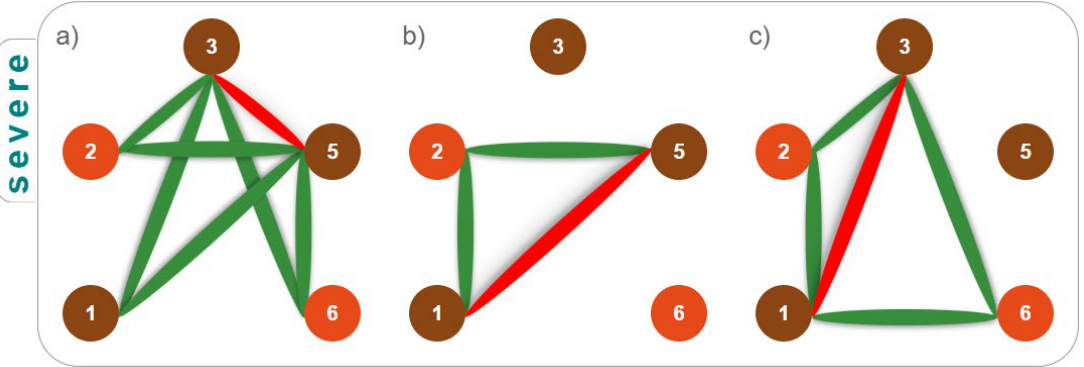
Figure 3. Pattern of methylations in severe ADHD subjects. Methylated CpGs are represented with a brown circle while the demethylated ones are depicted in orange. The red connector links the two CpGs that are behaving like a “seesaw”. The triplet is then completed with a third CpG, always found within the multiplied pair, which is reached by the green connectors. In severe ADHD subjects, CpGs 3 and 5 ( a ), CpGs 1 and 5 ( b ), and CpGs 1 and 3 ( c ) compose such